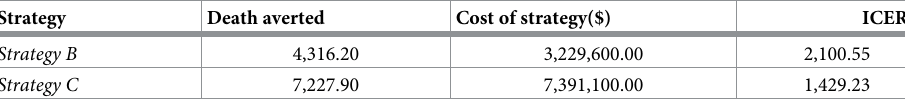
Table 13. ICER of control strategies in the order of death averted.